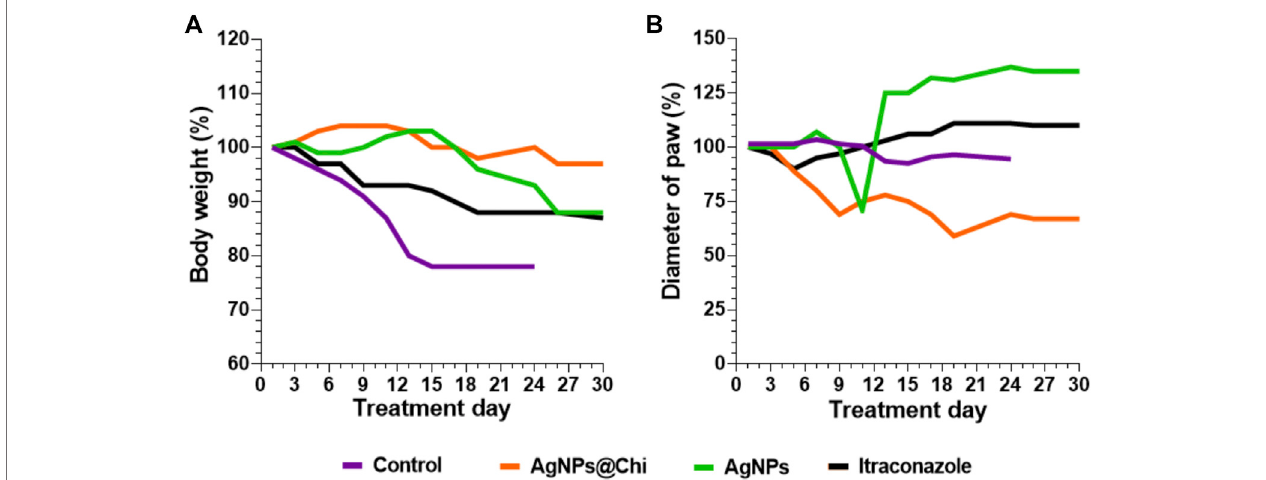
FIGURE7 | Paw diameter and body weight evaluationin mice infected with S. brasiliensis .C57BL/6mice were subcutaneously infected with yeasts (5 ×10 6 cells/ 25 µl). The injuries were evident 15 days ’ post-infection, then topical (silver nanocomposites) or intravenous (ITC) antifungal treatment was started. Mice from the nanocomposites and ITC groups were treated and followed up to day 30. The mice weight (A) and the in fl amed paw diameter (B) from each tested group were